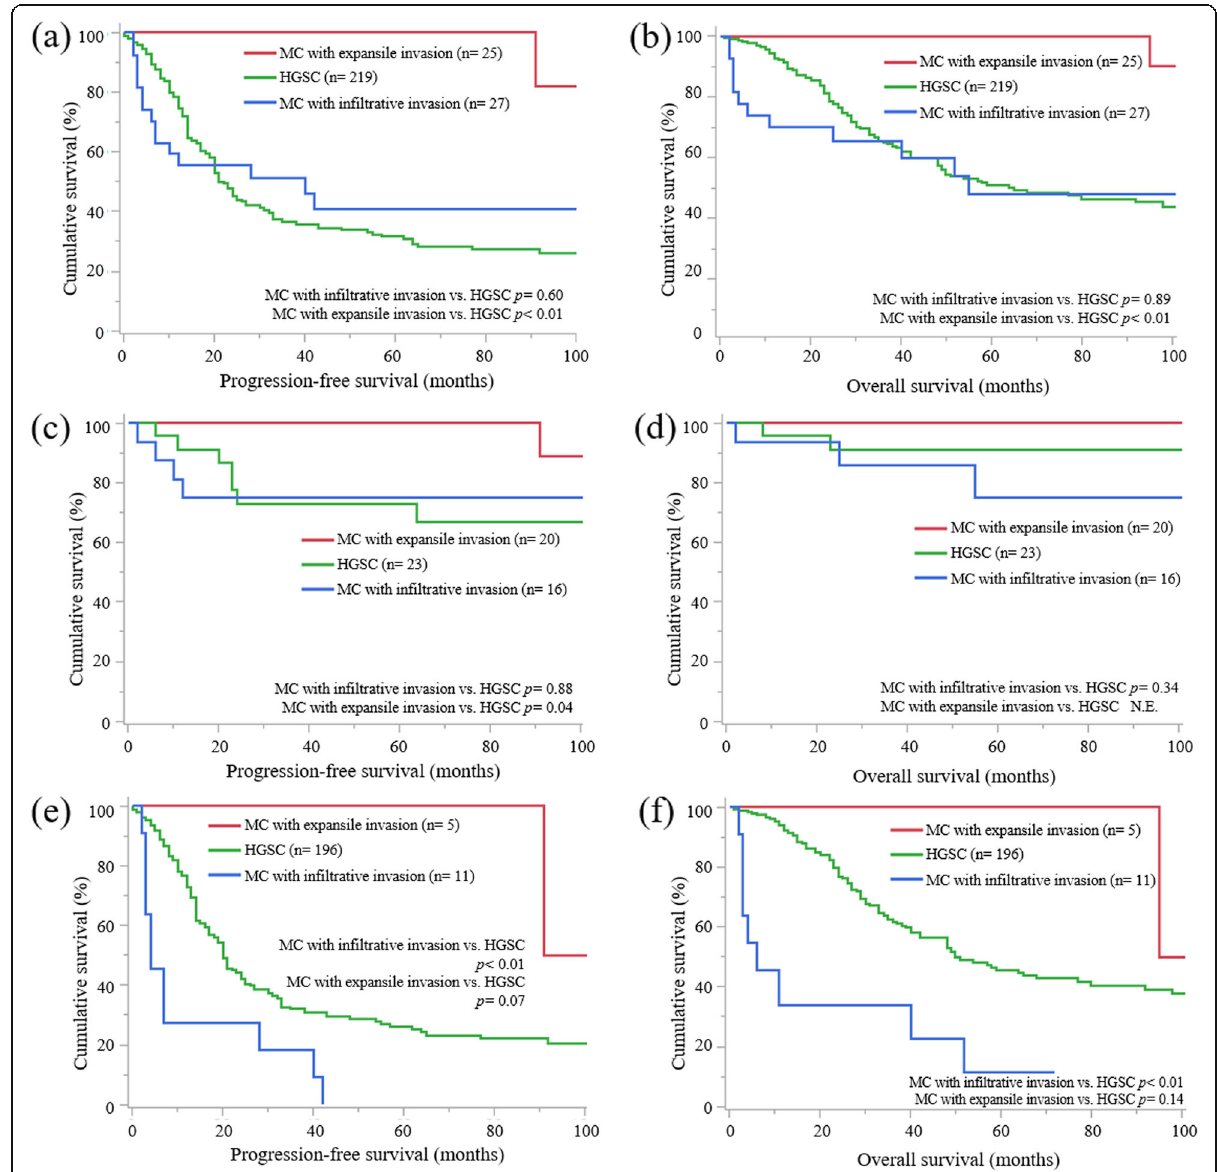
Fig. 3 Survival analysis of mucinous carcinoma with infiltrative or expansile invasion and high-grade serous carcinoma. ( A ) Progression-free survival (PFS) curves of all cases of mucinous carcinoma (MC) with infiltrative invasion, MC with expansile invasion, and high-grade serous carcinoma (HGSC). HGSC has a worse prognosis than MC with expansile invasion ( p < 0.01), and there is no statistically significant difference between MC with infiltrative invasion and HGSC ( p = 0.60). ( B ) overall survival (OS) curves of all cases of MC with infiltrative invasion, MC with expansile invasion, and HGSC. HGSC has a worse prognosis than MC with expansile invasion ( p < 0.01), and there is no statistically significant difference between MC with infiltrative invasion and HGSC ( p = 0.89). ( C ) PFS curves of cases of MC with infiltrative invasion, MC with expansile invasion, and HGSC at International Federation of Gynecology and Obstetrics (FIGO) stage I. MC with expansile invasion has a better prognosis than HGSC ( p = 0.04), and there is no statistically significant difference between MC with infiltrative invasion and HGSC ( p = 0.88). ( D ) OS curves of cases of MC with infiltrative invasion, MC with expansile invasion, and HGSC at FIGO stage I. There is no statistically significant difference between MC with infiltrative invasion and HGSC ( p = 0.34); statistical significance between MC with expansile invasion and HGSC is not evaluable. ( E ) PFS curves of cases of MC with infiltrative invasion, MC with expansile invasion, and HGSC at FIGO stages II to IV. MC with infiltrative invasion has a worse prognosis than HGSC ( p < 0.01), and there is no statistically significant difference between MC with expansile invasion and HGSC ( p = 0.07). ( F ) OS curves of cases of MC with infiltrative invasion, MC with expansile invasion, and HGSC at FIGO stages II to IV. MC with infiltrative invasion has a worse prognosis than HGSC ( p < 0.01), and there is no statistically significant difference between MC with expansile invasion and HGSC ( p =